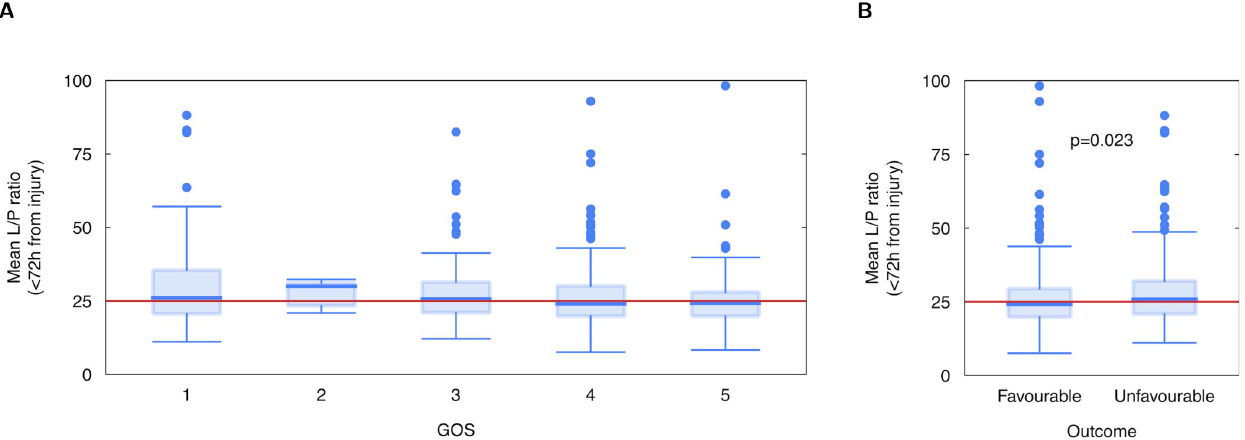
Fig 1. Boxplots of individual patients’ mean lactate-pyruvate ratio (LPR) over the first 72h following injury, by (A) Glasgow Outcome Score (GOS) and (B) dichotomised GOS.